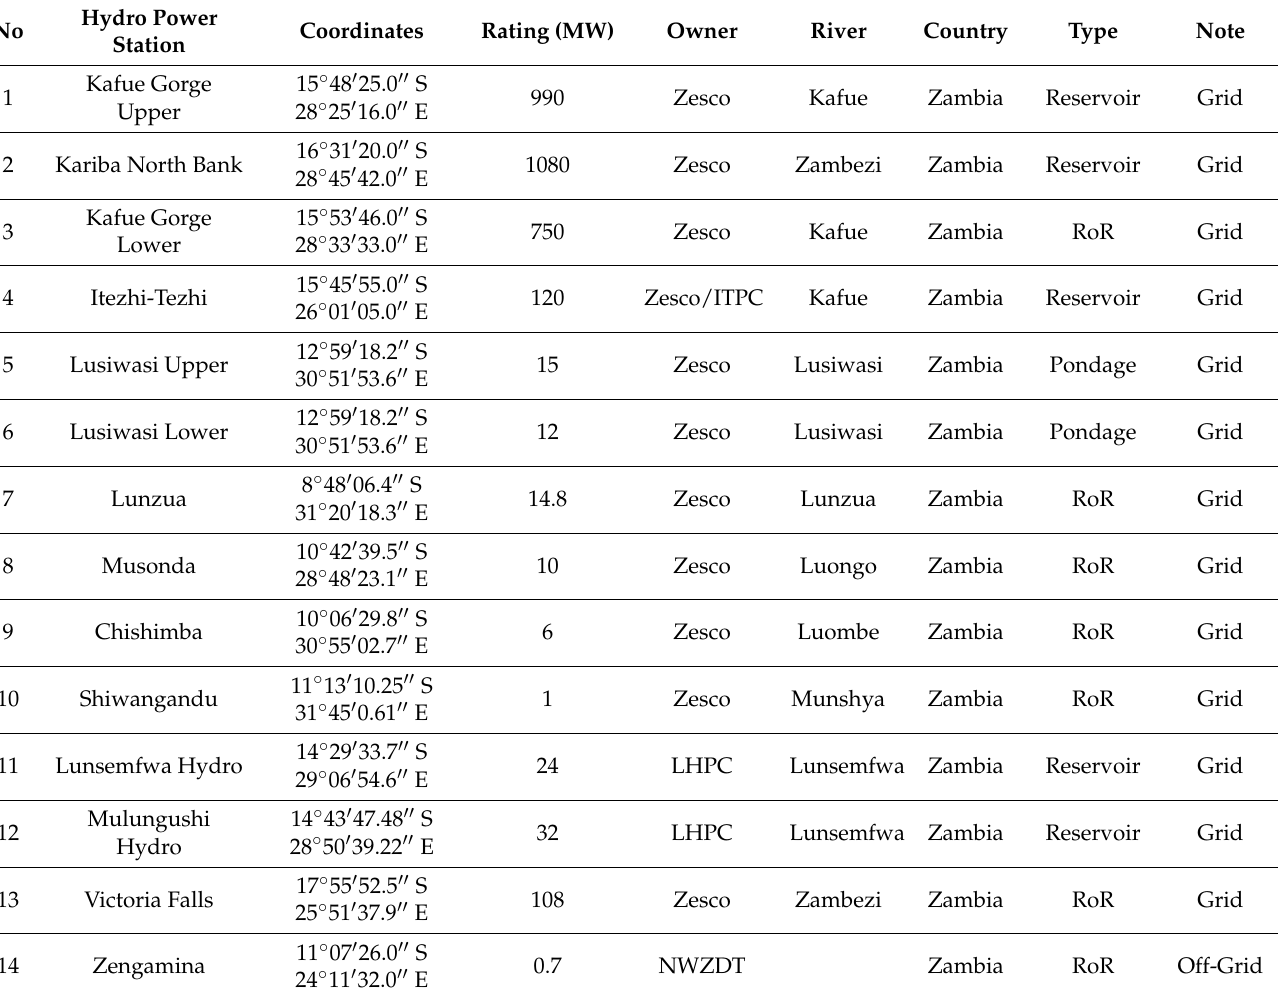
Table 2. Showing the identification of the hydro sites under